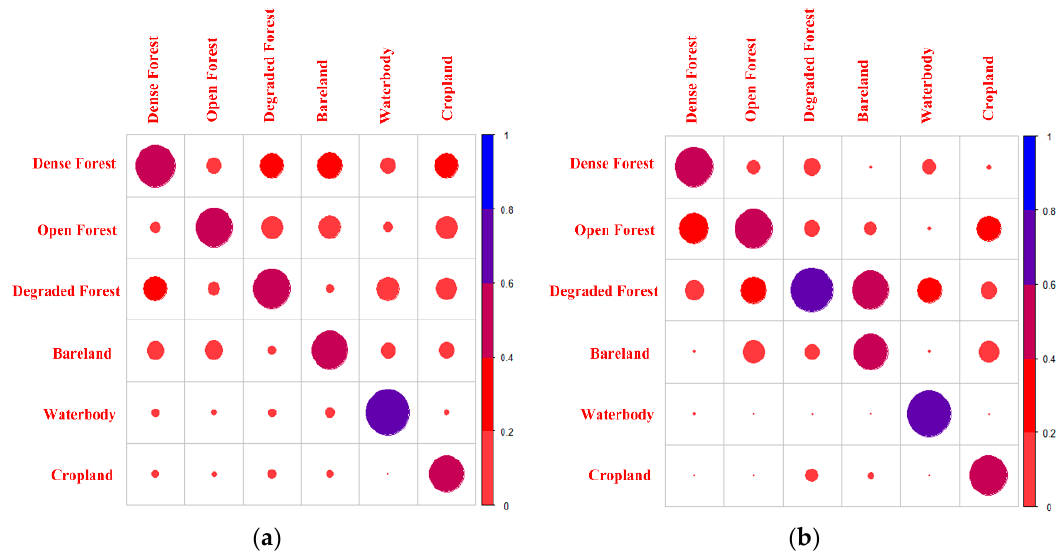
Figure 5. ( a ) Probability transition matrix for 1998–08. ( b ) Probability transition matrix for 2008–2018.